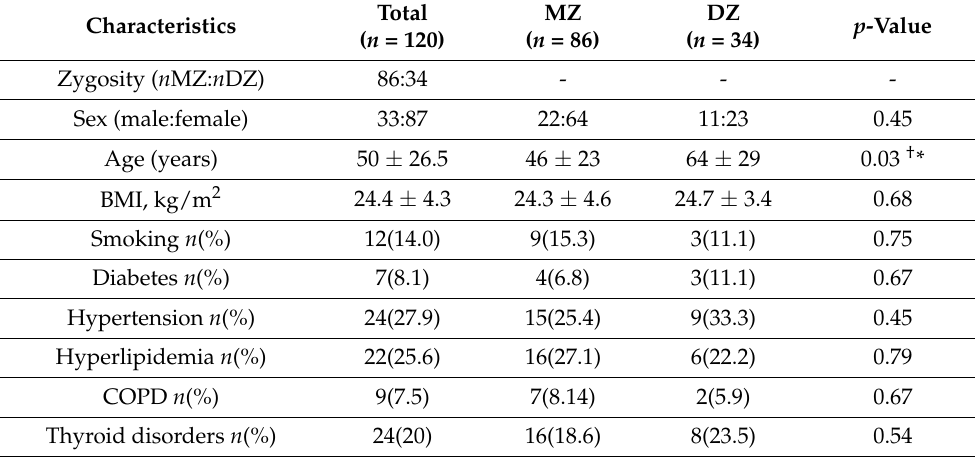
Table 1. Characteristics of the MZ and DZ twin study populations, Body mass index (BMI) and other continuous variables with a normal distribution are represented by the mean and standard deviation and those with a non-normal distribution are represented by the median, interquartile range (age). † The results of the non-parametric Mann-Whitney U-test are displayed. For all other continuous variables, the independent-sample t -test was used to determine the p -value. p -values are obtained for dichotomous variables using the Chi-square test. Asterisks (*) are used to indicate significant results. Characteristics